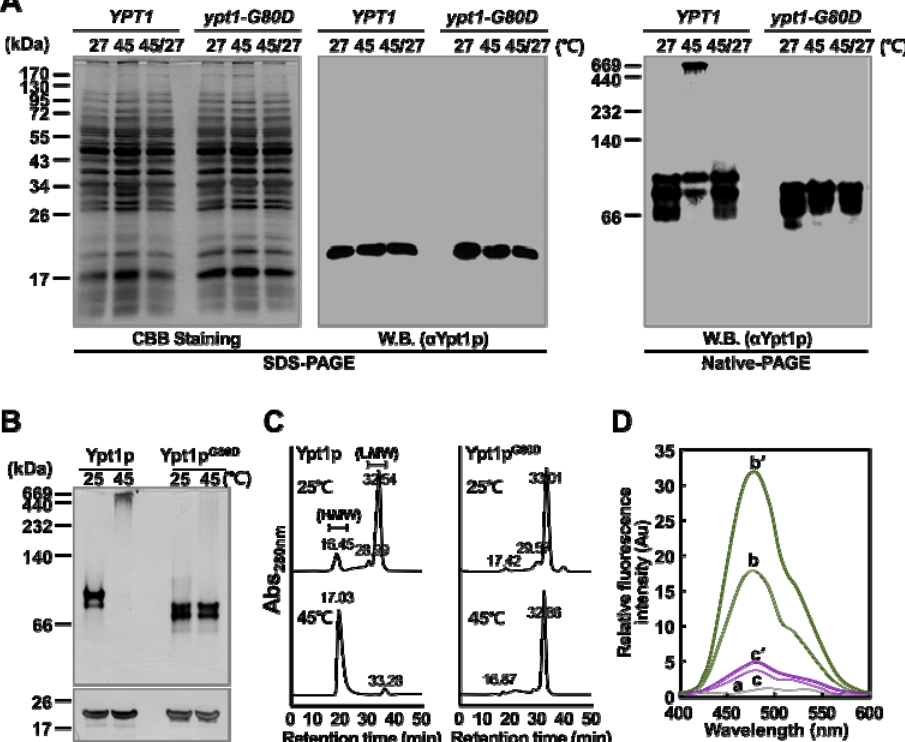
Figure 3. Heat-Shock Induces Changes in the Molecular State of Ypt1p but not Ypt1p G80D . ( A ) Changes in the molecular state of Ypt1p and Ypt1p G80D in vivo. YPT1 and ypt1-G80D cells were grown in YPD medium (1 × 10 8 cells/mL) and incubated at 27 ◦ C or 45 ◦ C for 45 min. Half of the heat-treated cells were transferred to an equal volume of fresh YPD medium containing 100 µ g/mL cycloheximide and allowed to recover for 10 h at 27 ◦ C (45/27). Total protein extracts (10 µ g) were analyzed by SDS-PAGE, and proteins were visualized by CBB staining (left image). In addition, total protein extracts (50 µ g) were analyzed by immunoblotting with a polyclonal anti-Ypt1p antibody after fractionation by SDS-PAGE (middle image) or native-PAGE (right image). W.B., western blotting. ( B , C ) Changes in the molecular state of Ypt1p and Ypt1p G80D in vitro. ( B ) Purified bacterially expressed Ypt1p and Ypt1p G80D (3 µ g/ µ L) were incubated at 25 ◦ C or 45 ◦ C for 30 min, subjected to native-PAGE (upper image) or SDS-PAGE (lower image), and then silver-stained. ( C ) SEC analysis of the protein solutions described in ( B ). ( D ) A bis-ANS binding assay to identify heat-shock-induced exposure of hydrophobic domains in Ypt1p and Ypt1p G80D . Fluorescence spectra of bis-ANS were measured with excitation at 380 nm and emission scanning at 400–600 nm. The samples used were 10 µ M bis-ANS (a), 10 µ M bis-ANS plus 30 µ M Ypt1p incubated at 25 ◦ C (b) or 45 ◦ C (b (cid:48) ), and 10 µ M bis-ANS plus 30 µ M Ypt1p G80D incubated at 25 ◦ C (c) or 45 ◦ C (c (cid:48) ) for 20